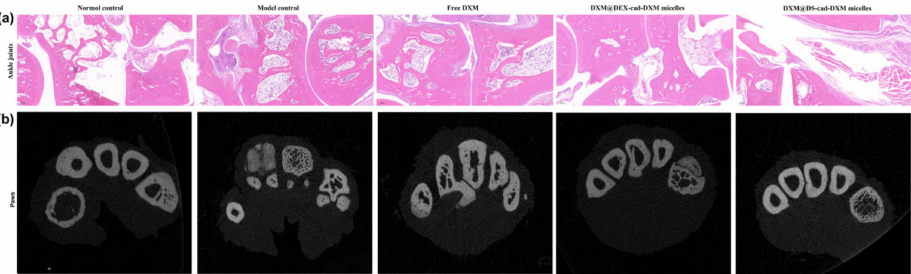
Figure 8. HE staining ( a ) and micro-CT images ( b ) of the inflamed joints from AIA rats after being treated with DXM@DS-cad-DXM micelles and DXM@DEX-cad-DXM micelles. Black arrows indicate pannus formation; green arrows indicate bone destruction. Scale bar = 200 µ m.